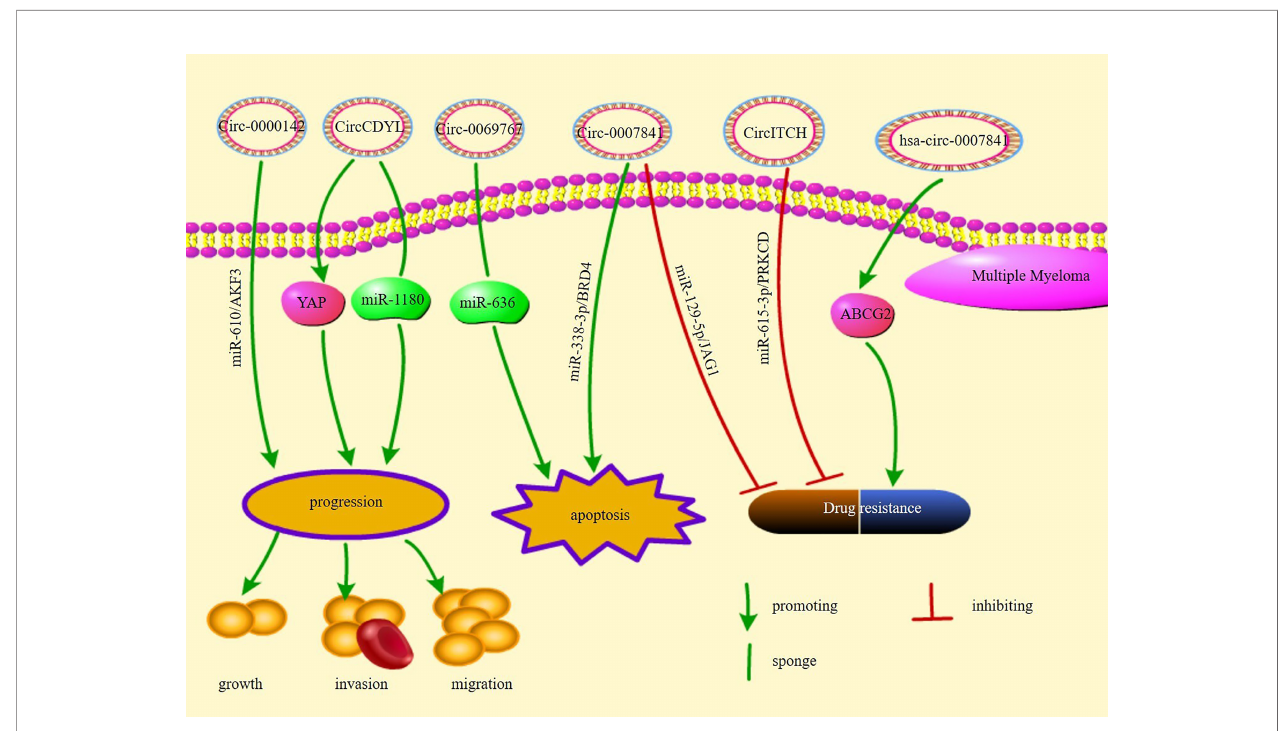
FIGURE 3 | The regulatory mechanisms and their functions of circRNAs in multiple myeloma.